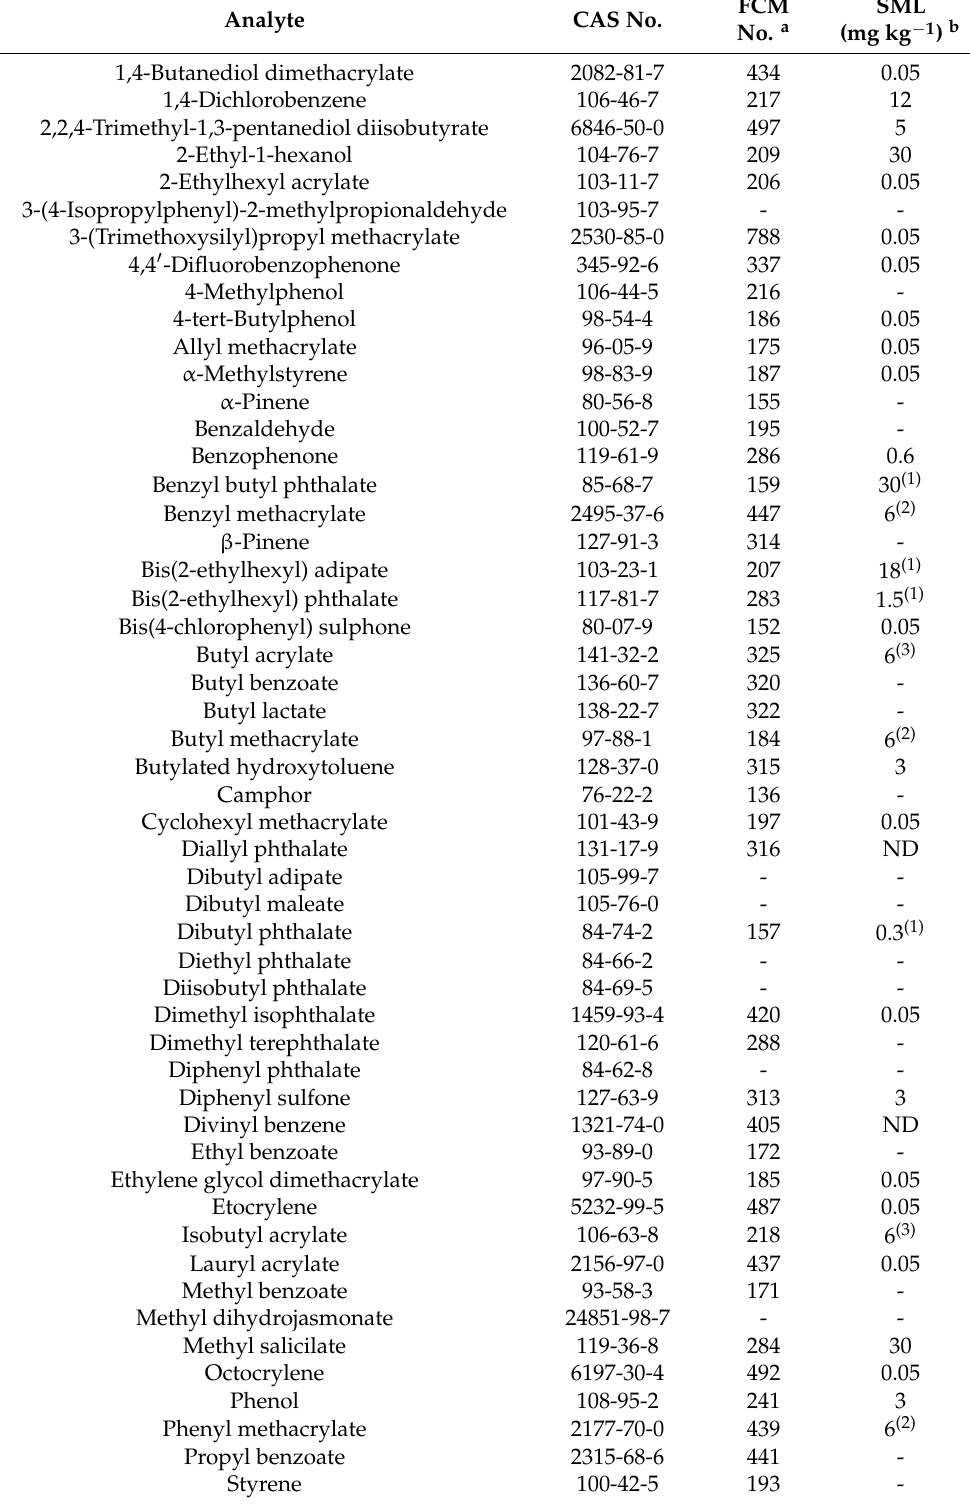
Table 1. List of target analytes and their specific migration limits